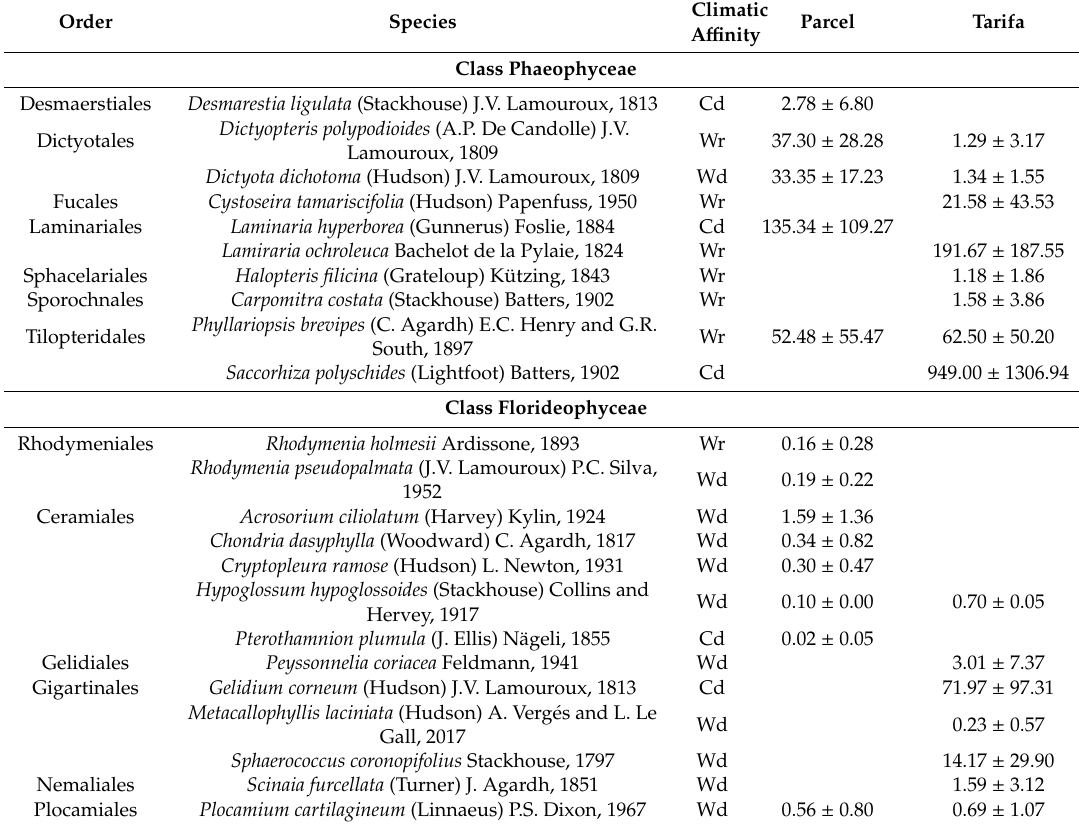
Table2. ListofalgaespeciesidentifiedinParcelandTarifalocations, alongwiththeirbiomassabundance (g wet weight per 0.25 m 2 , mean ± SD, n = 12) and its climatic a ffi nity: cold-water Atlantic-boreal (Cd), warm-water Lusitanian species (Wr), or widely distributed (Wd) species. All taxonomic authorities were verified through cited references in [19] (December